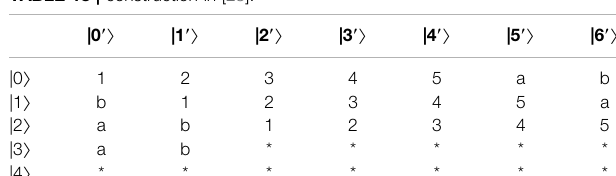
TABLE 13 | 5×3+2×4=23-member. TABLE 18 | construction in